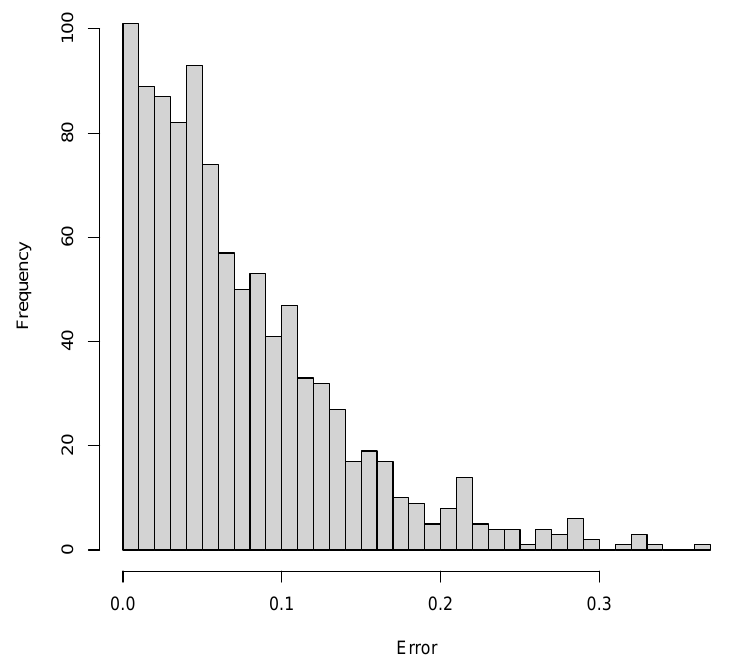
Figure 12. Histogram of the error ∆ 1